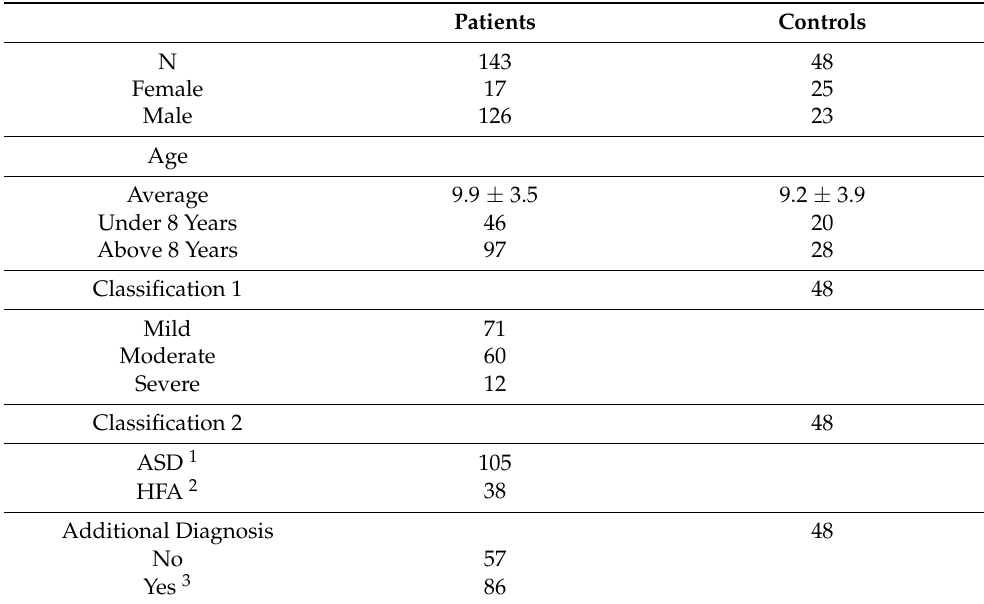
Table 3. Description of patients and controls used in this